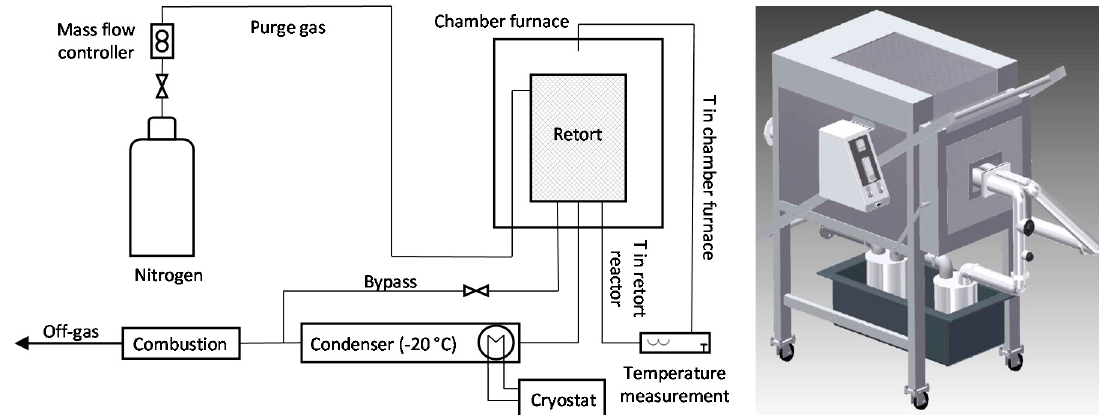
Figure 5. Retort furnace for pyrolysis (Figure: Kai Schlögel).